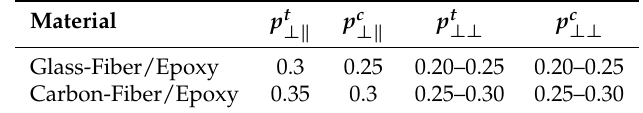
Table 1. Typical values of inclination parameters for fiber reinforced plastics recommended by Puck et al. [56].